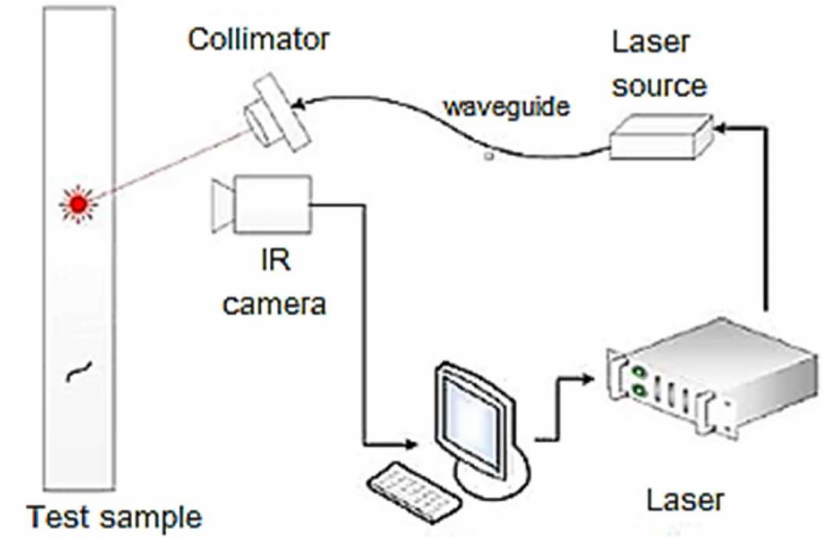
Figure 17. Infrared thermography system, adapted from